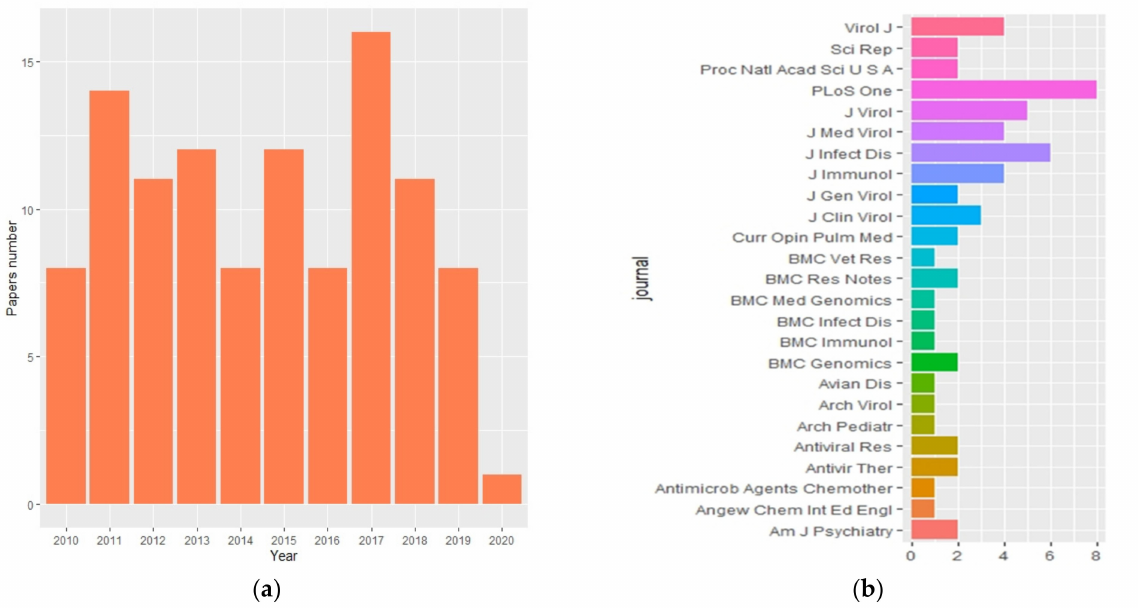
Figure 1. ( a ) Publications with the words “influenza A H1N1” and “genetic susceptibility” published between January 2009 to May 2020. ( b ) Top 25 journals where the 119 articles were